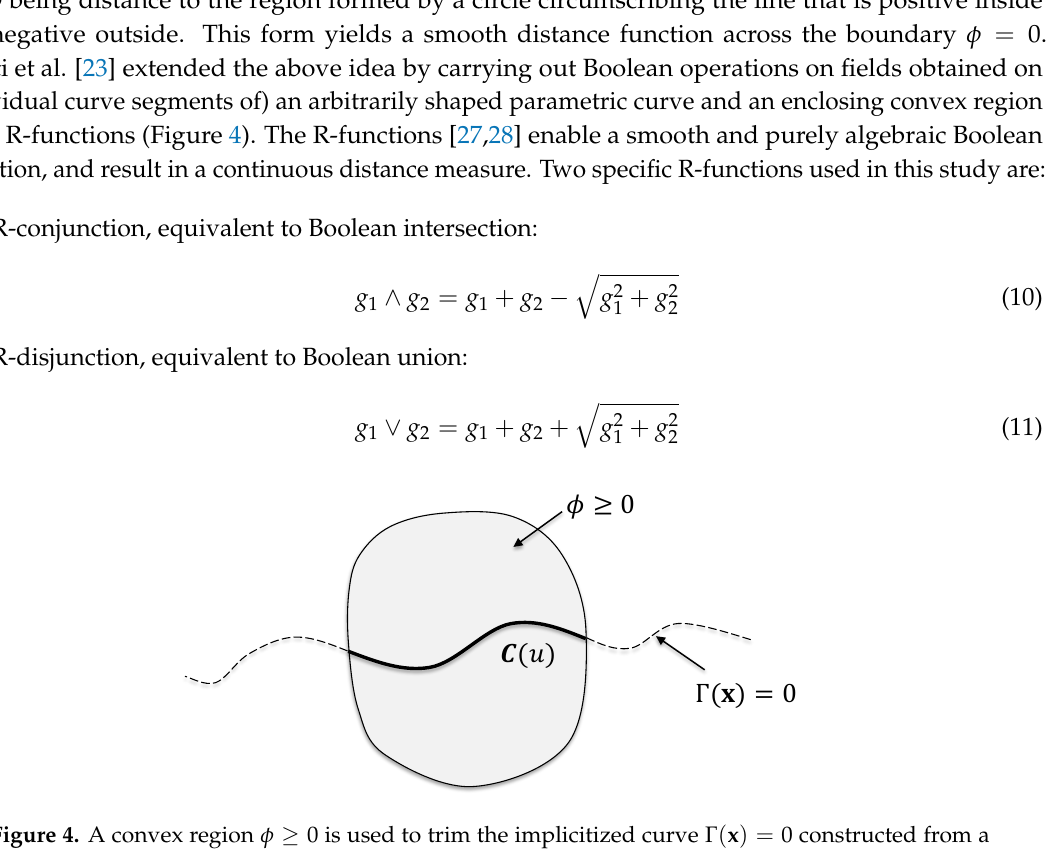
Figure 4. A convex region φ ≥ 0 is used to trim the implicitized curve Γ ( x ) = 0 constructed from a parametric curve C ( u )